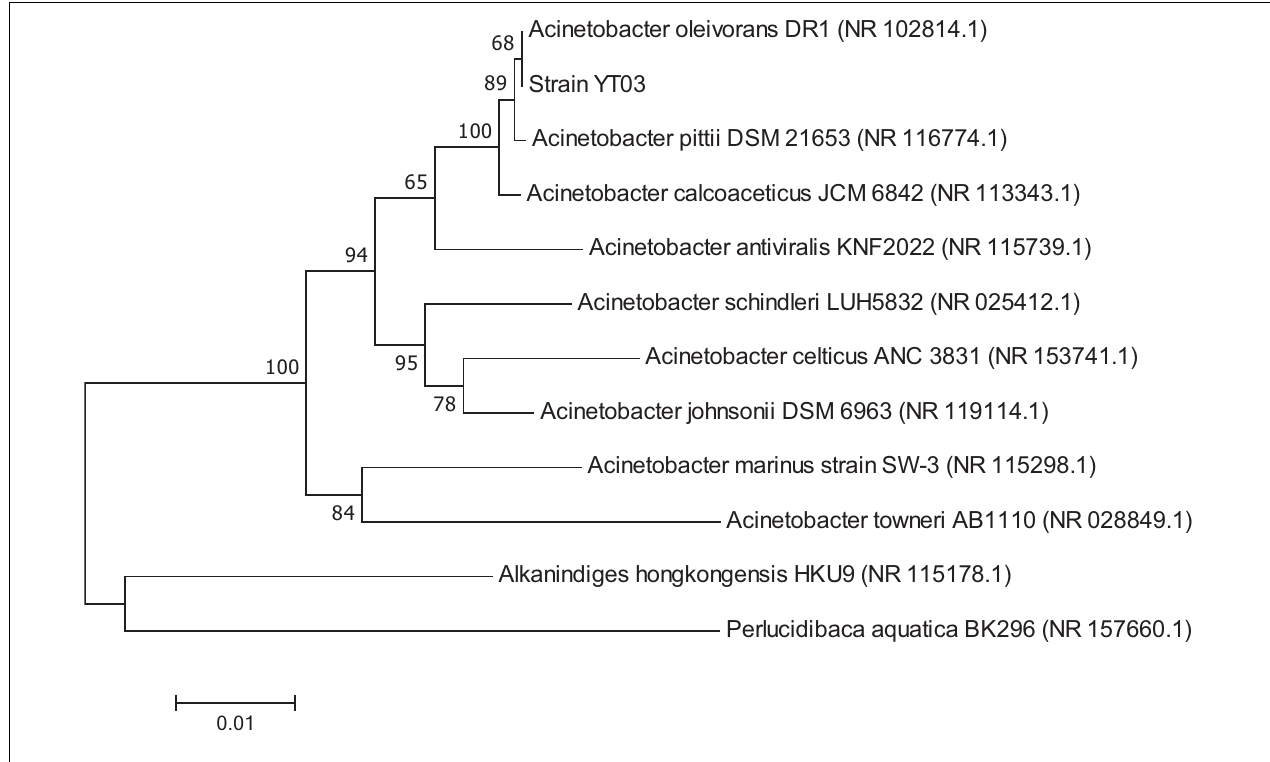
FIGURE 1 | Phylogenetic tree derived from neighbor-joining analysis of partial 16S rRNA gene sequence.